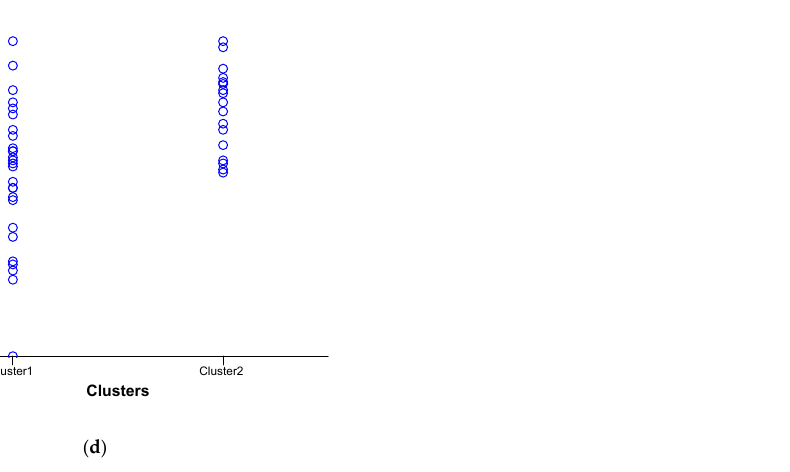
Figure 13. Graphical representation of the clusters formulated from the weighted subjective evaluation of the NASA TLX scales and the overall workload. ( a ) Mental and physical demands. ( b ) Temporal demand and performance. ( c ) Frustration and effort. ( d ) Workload.